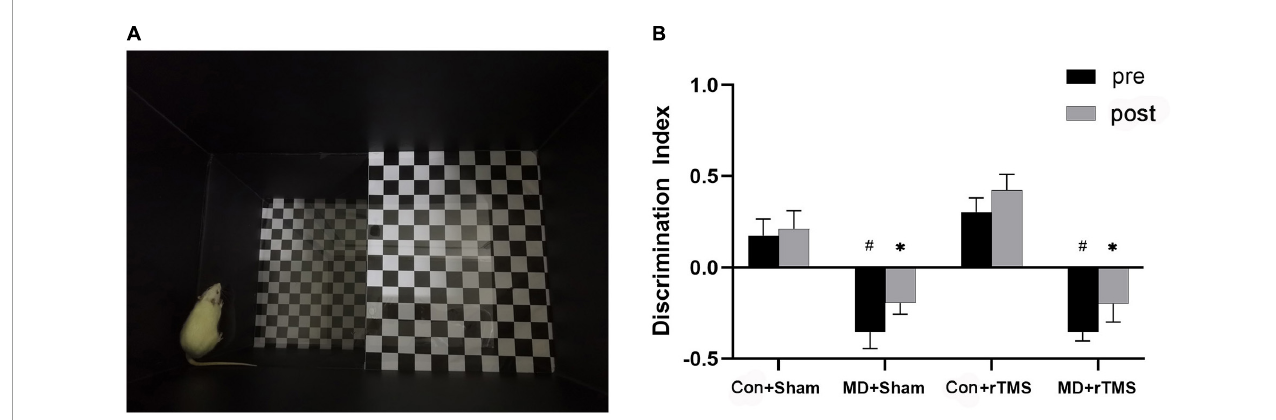
FIGURE3 (A) An adult rat is exploring the “down” zone in the visual cliff device, while the actual light intensity during behavioral experiments is much dimmer than the environment in this picture. (B) Discrimination index was used to quantify the depth perception of rats by repeated-measures analysis of variance (ANOVA) with Bonferroni correction. After repetitive transcranial magnetic stimulation (rTMS), the discrimination index of monocular deprivation (MD) rats did not differ significantly from the baseline and was significantly lower than in Control rats. Data are expressed as mean ± standard error of the mean (SEM). # represents significant comparison among MD and Con+Sham group before receiving stimulation, p < 0.05; ∗ indicates significant comparison among MD and Con+Sham groups after receiving the stimulation, p < 0.05.